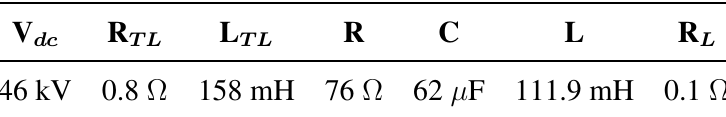
Table 1. Case I: System